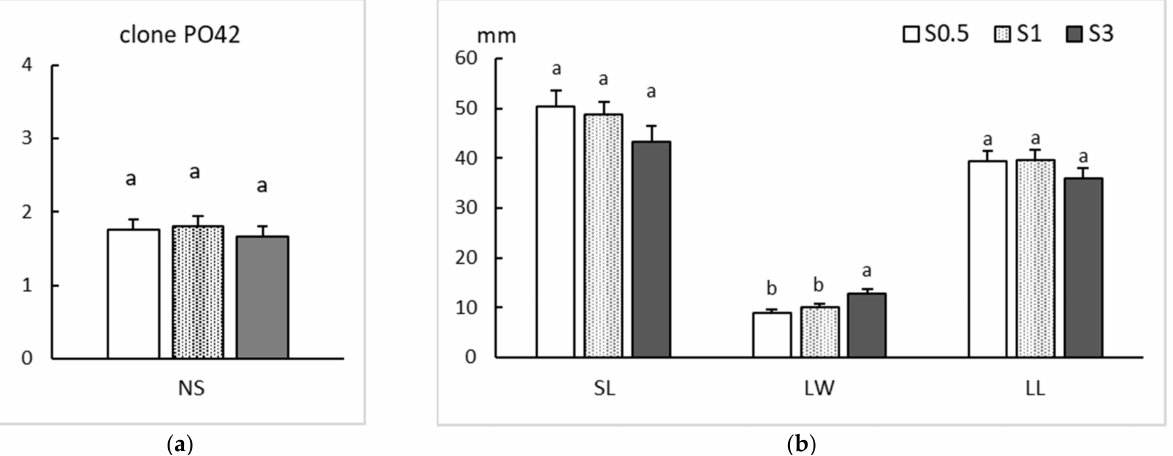
Figure 4. Effect of sucrose supplementation (0.5, 1 and 3%) on proliferation rates of apical sections of clone PO42 shoots cultured by temporary immersion. ( a ) Number of shoots (NS). ( b ) Length of the longest shoot (SL) and length (LL) and width (LW) of the largest leaf per explant. Values are the mean ± standard error from three replicate trials each with 2 bioreactors (72 explants/treatment). For each variable, different letters indicate significant differences at p <